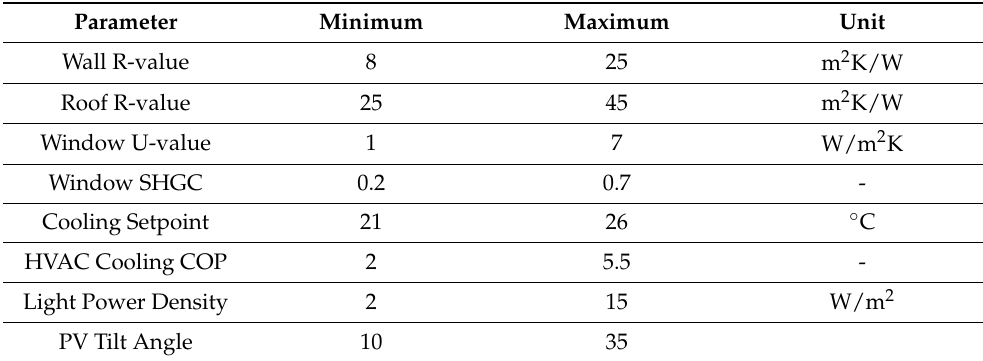
Table 2. Respective ranges for the variables used in developing ANN training data.